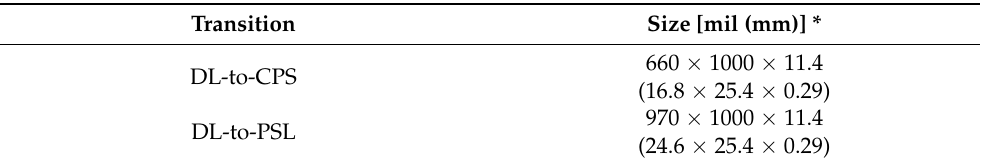
Figure 17. Fabricated transitions in back-to-back configurations: ( a ) DL-to-CPS transition, ( b ) DL-to-PSL transition. Table 4. Overall sizes of the fabricated DL-to-BL transitions.